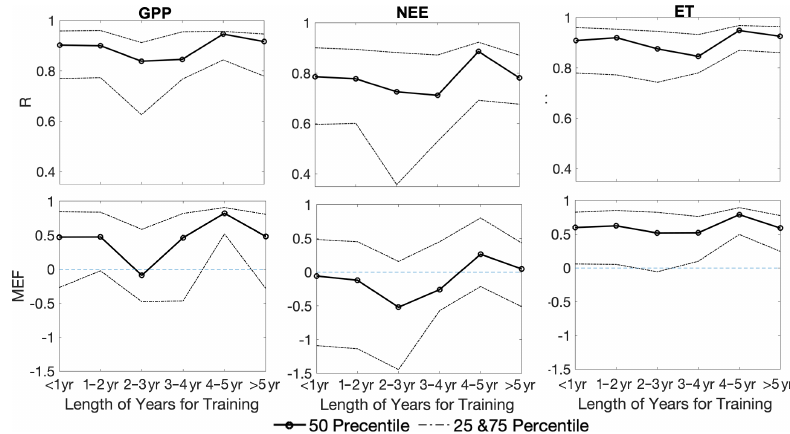
Figure 7. Correlation metrics ( R and MEF) changing with different assimilation periods for CARDAMOM outputs (GPP, NEE, or ET) versus FLUXNET tower measurements. The solid lines are the 50th percentile of the R and MEF, and the dashed lines represent the 25th and 75th